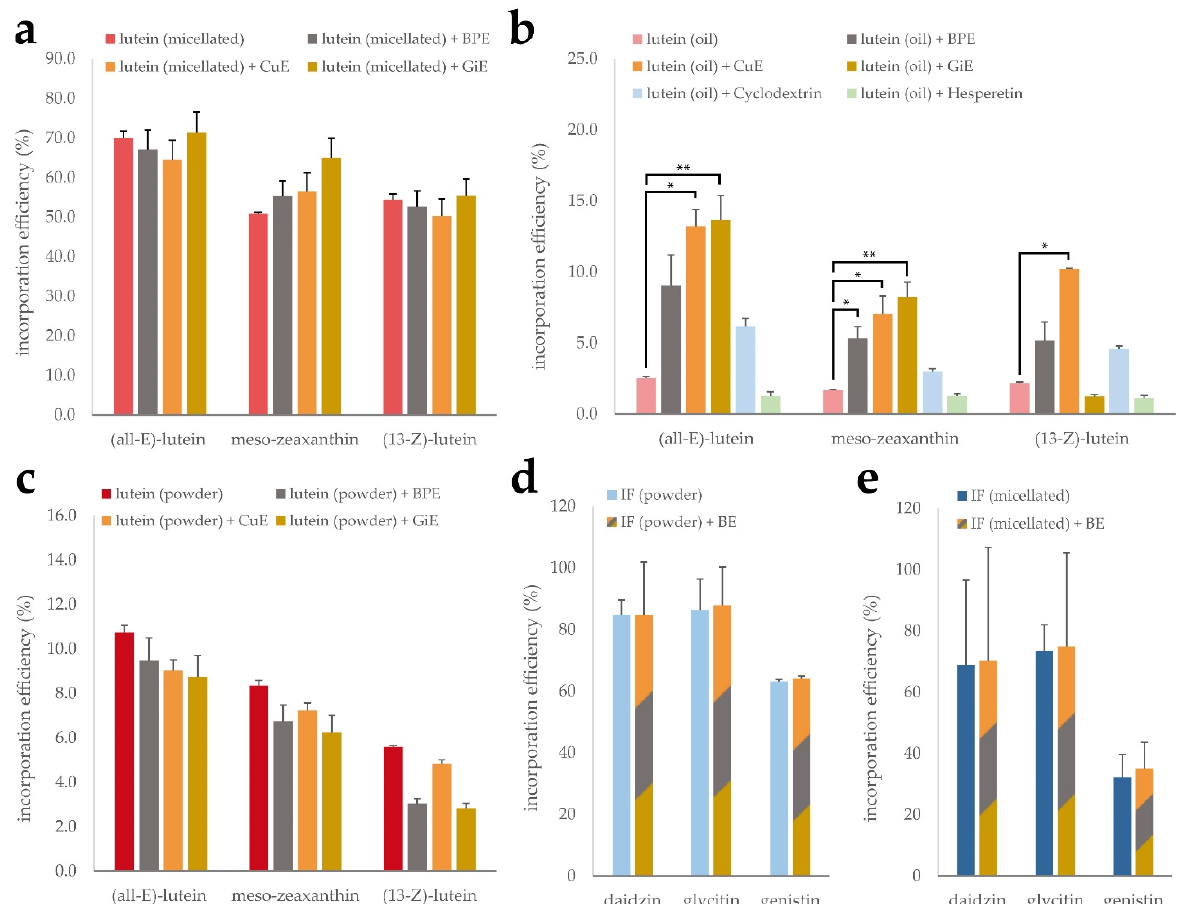
Figure 4. Mixed micelle incorporation efficiency of micellated lutein ( a ), lutein oil ( b ) and free lutein powder ( c ) in combination with CuE, BPE and GiE, respectively, as well as CD ‐ complexed and micellated isoflavones (IF) with a mixture of the extracts ( d , e ). Error bars represent mean ± SEM ( n = 3). Statistically significant differences are denoted as* ( p ≤ 0.05) and ** ( ≤ 0.01).